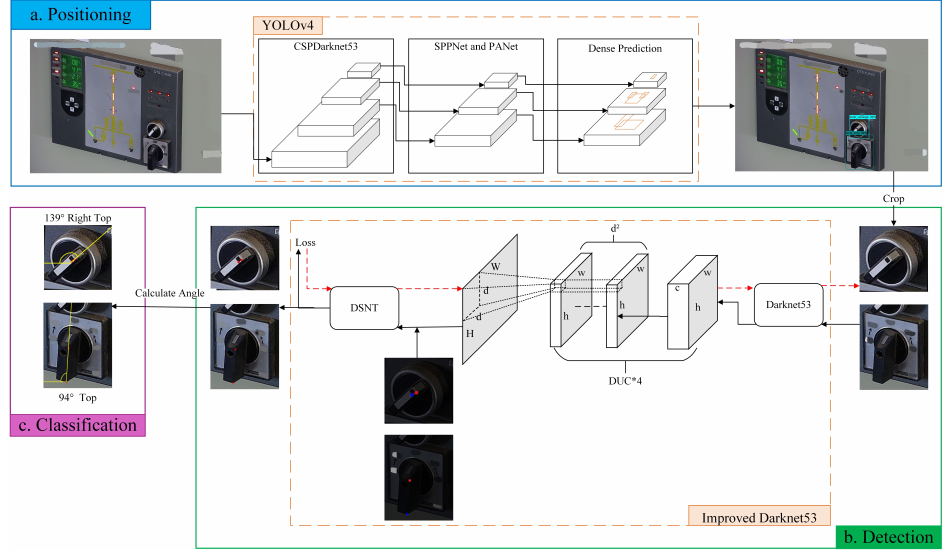
Figure 4. The overall framework of the knob gear recognition model. Panel ( a ) is the knob po- sitioning module; ( b ) is the detection module of the key point of the knob; ( c ) is the knob gear classification